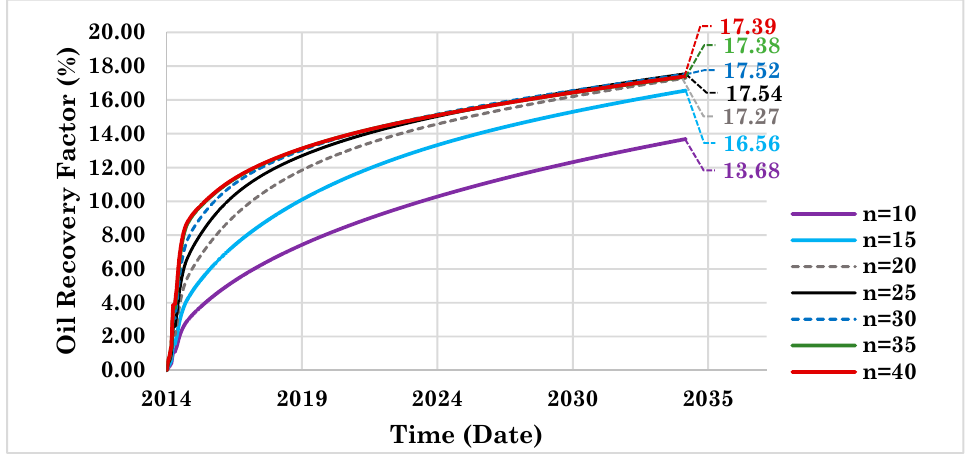
Figure 2. Primary (natural depletion) recovery factor at different number of fracture stages.